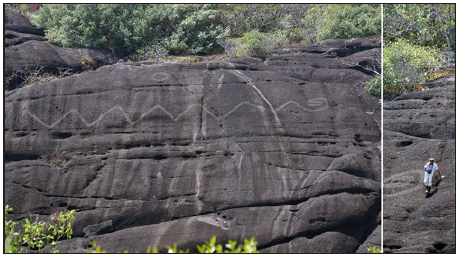
Figure 1: Monumental double headed snake (c. 35 meters long) on the façade of Cerro Palomazón Hill (Photo: JR Oliver).